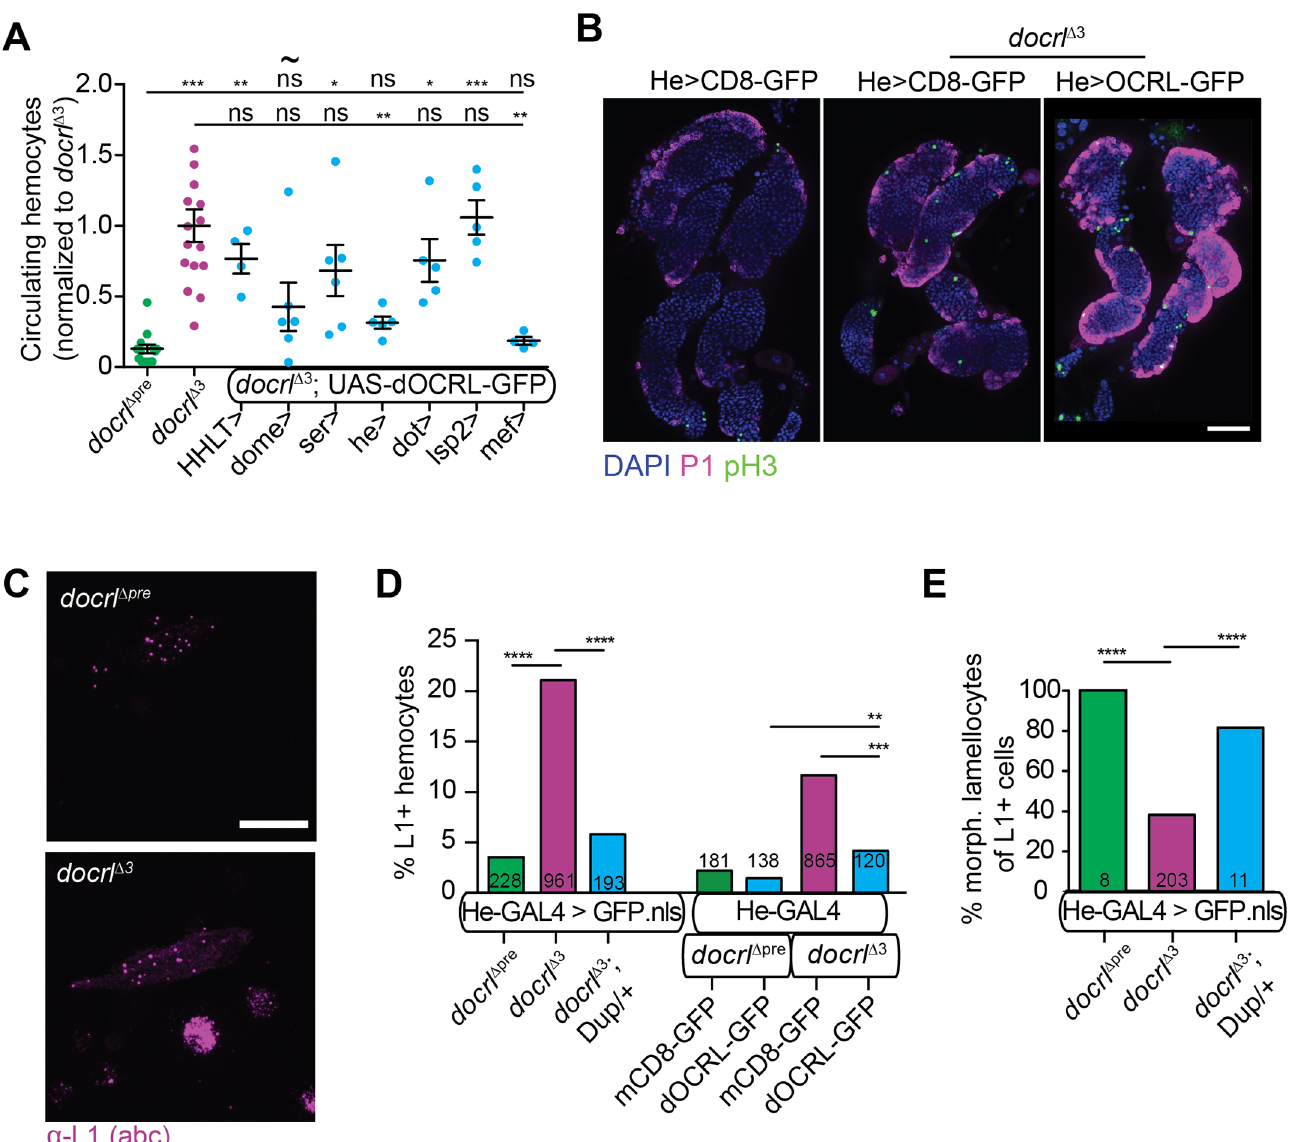
Fig 2. Aberrant hemocyte differentiation and activation in docrl mutants. (A) Re-expression of dOCRL-GFP rescue transgene in hemocytes(he- GAL4) and also in muscle (mef2-GAL4), but not lymph gland (dome-GAL4 and ser-GAL4), nephrocytes (dot-GAL4), or fat body (lsp2-GAL4) rescues hemocyte numberin docrl Δ 3 larvae. Data are presented as mean +/- SEM. For dome-GAL4(marked with ~) only very small larvaewere recovered, which may have exhibitedlower hemocyte numberdue to developmental stage. (B) 2D projection of confocalimages of lymph glands. P1 (magenta) labels differentiatinghemocytes and phospho-H3 (green) labels dividingcells. (C) 2D projection of confocalimage of hemocytes stainedfor the lamellocytemarker L1 (magenta). Scale bar is 20 μ m. (D) Quantificationof L1 staining.Greater numbersof docrl Δ 3 hemocytes are L1-positive (left). This defect is partially rescuedby re-expressionof dOCRL-GFP in hemocytes (right). (E) Most docrl Δ 3 L1-positive cells do not exhibit normal lamellocytemorphology. Individual values in A represent independent samples of hemocytes collectedfrom 2–4 larvae. Sample N in panels D-E represent number of cells counted. Associated with S3